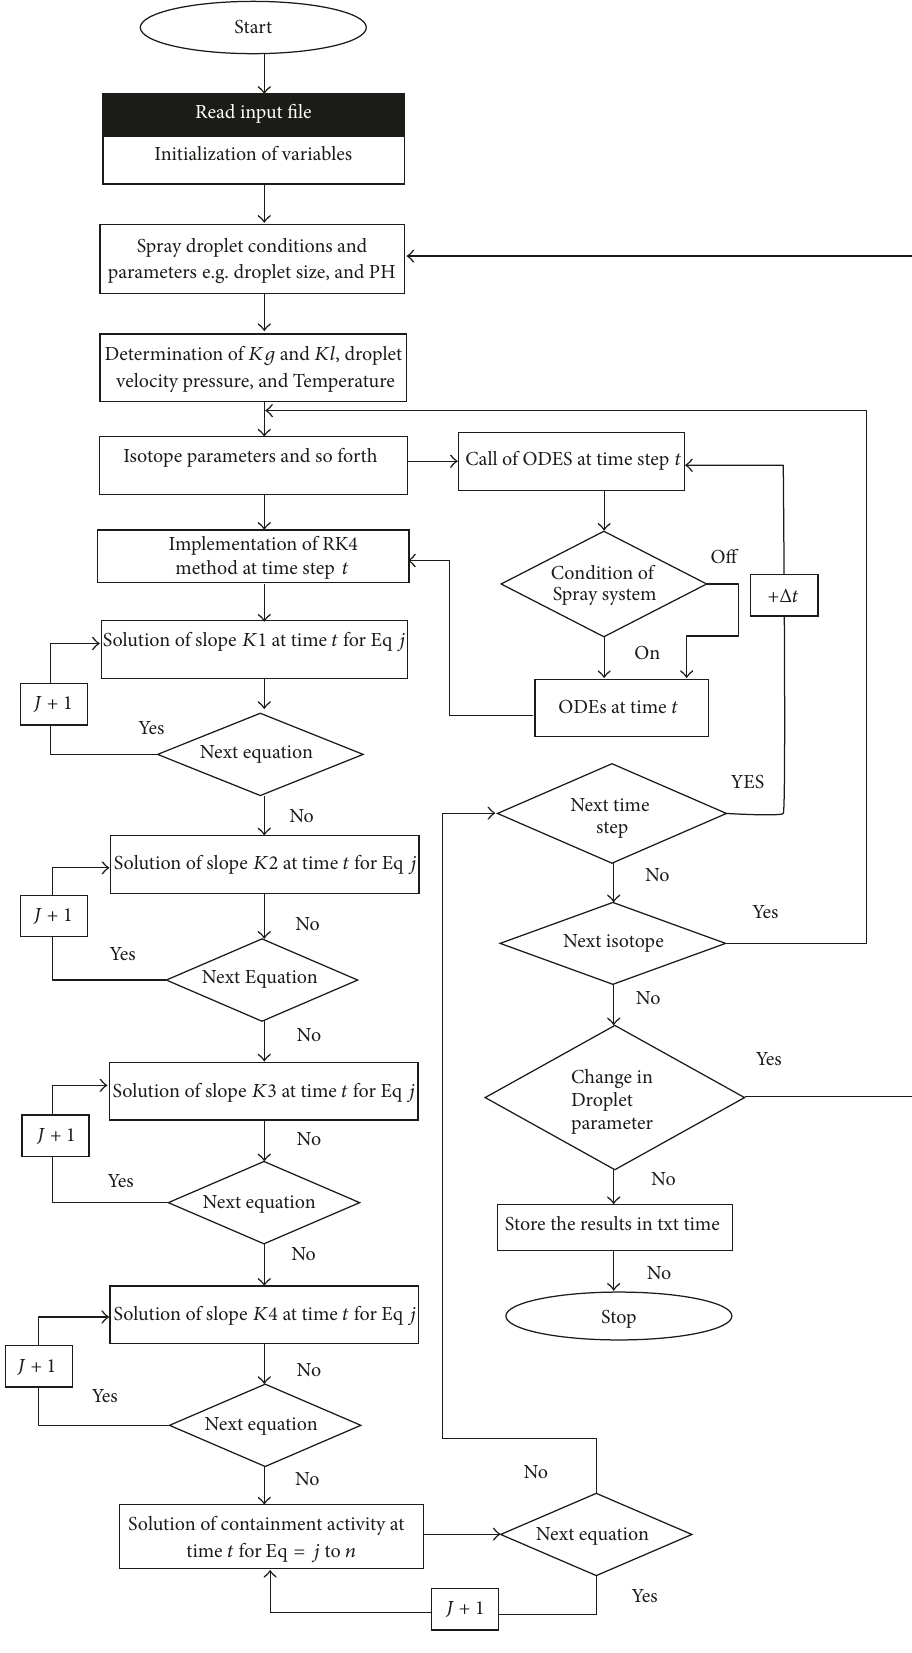
Figure 5: Flow diagram of a computer